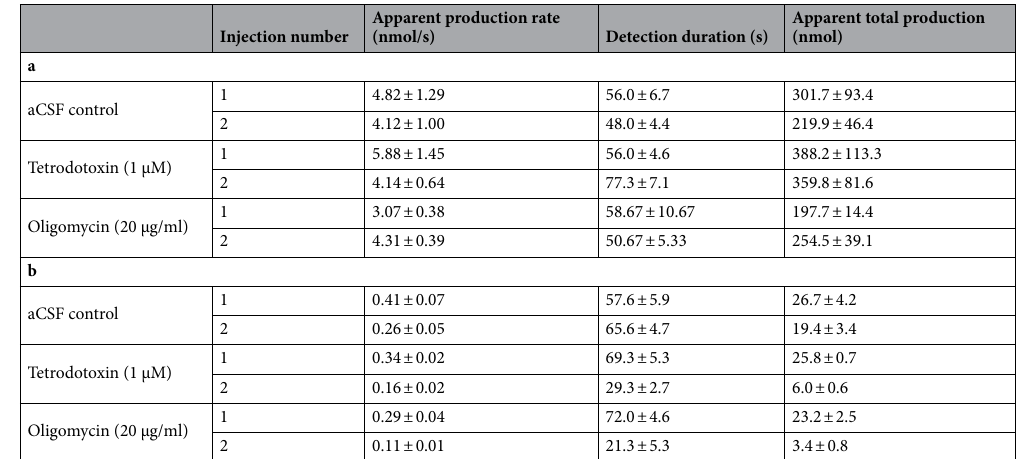
Table 2. a LDH activity—apparent [1- 13 C]lactate production rates. b PDH activity—apparent [ 13 C] bicarbonate production rates. All values are given as mean ± standard error of the mean. For TTX and OLI, Injection 1 is before incubation and injection 2 is after